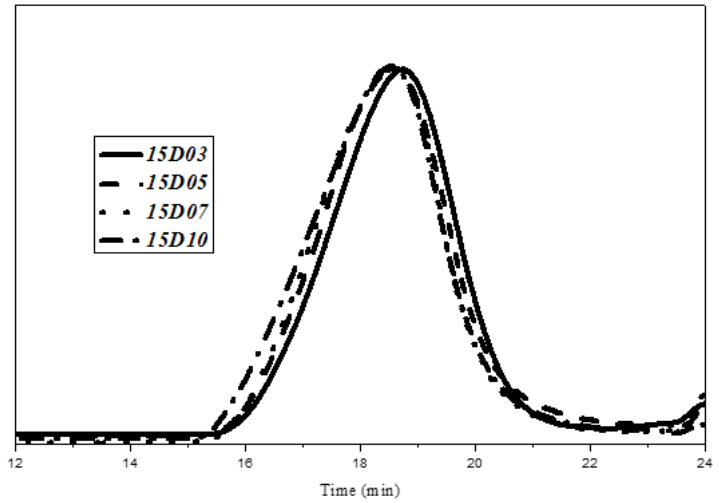
Figure 6. GPC curve of TPU with end-capping agent at concentration of 5.0 phm.